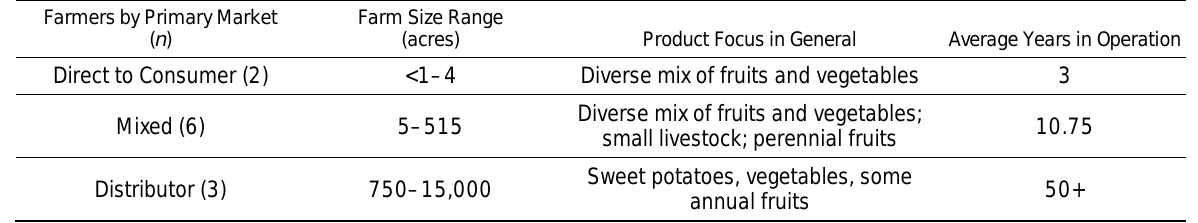
Table 3. Farmer Research Participants and Identifiers of Operation and Scale Farmers by Primary Market ( n )